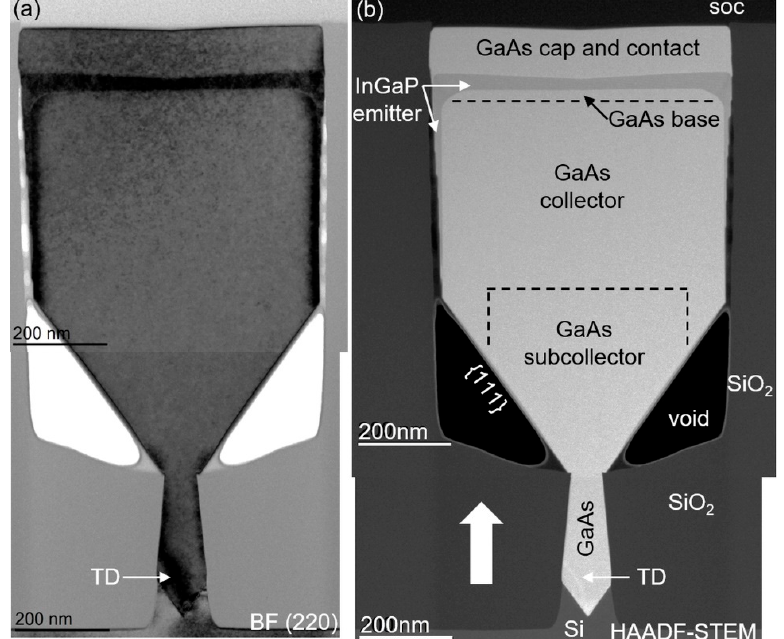
Figure 2. Cross-section (stitched) TEM images of a HBT layer stack viewed under ( a ) two-beam BF (220) and ( b ) HAADF-STEM conditions with all device layers indicated. The broad arrow points to the approximate off-center location for the longitudinal cut shown in Figure 3.